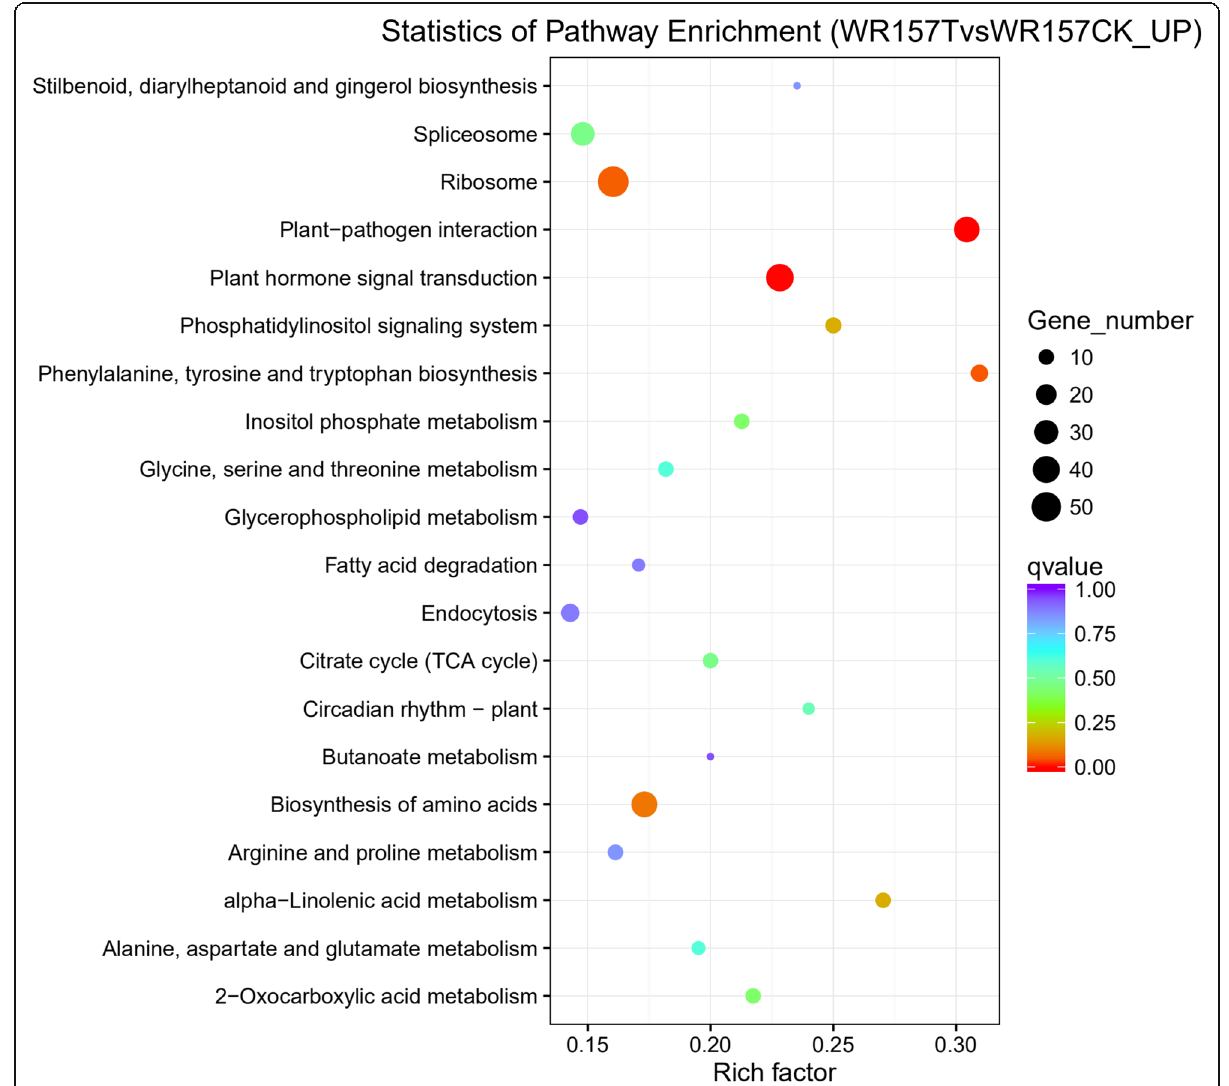
Fig. 7 Pathway enrichment for upregulated DEGs in WR157T and WR157CK according to the KEGG analysis. The color of the circle represents the q value, and the size of the circle represents the number of genes enriched in the pathway. The rich factor represents the ratio between the number of enriched DEGs in a pathway and the number of annotated genes, higher values of the Rich factor mean a higher degree of